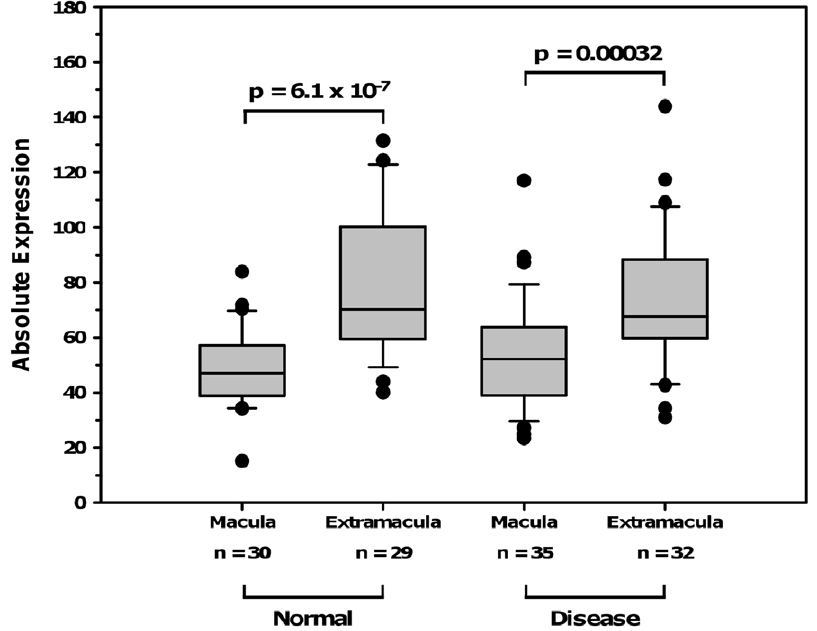
Figure 3. Results from gene expression studies in ROBO1 . Absolute expression of ROBO1 in the RPE-Choroid is plotted on the Y-axis, and values for the macula and extra macula are plotted for both normal eyes and eyes with all AMD subtypes.